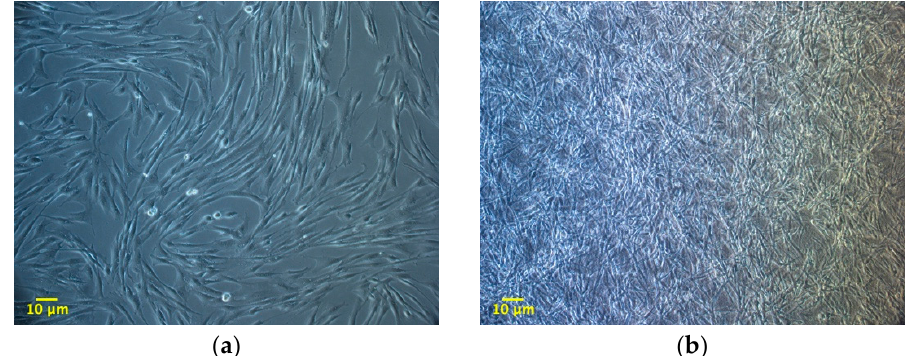
Figure 5. Morphology of adipose tissue derived stromal vascular fraction (SVF) cells (100×), expanded on the plastic surface ( a ) or within a 3D matrix prepared from PPP. ( b ) The cells were expanded until they reached about 90% of confluence on plastic (average 192 h). The morphology resembles what observed for ADMSCs cultures in the two different environments. Table 3. The average number of cells and cell number fold increase obtained from adipose tissue derived SVF cells expanded on plastic surface or inside a 3D matrix prepared from PPP. The cells were counted when plastic cultures reached about 90% of confluency (average 192 h) (n = 3).